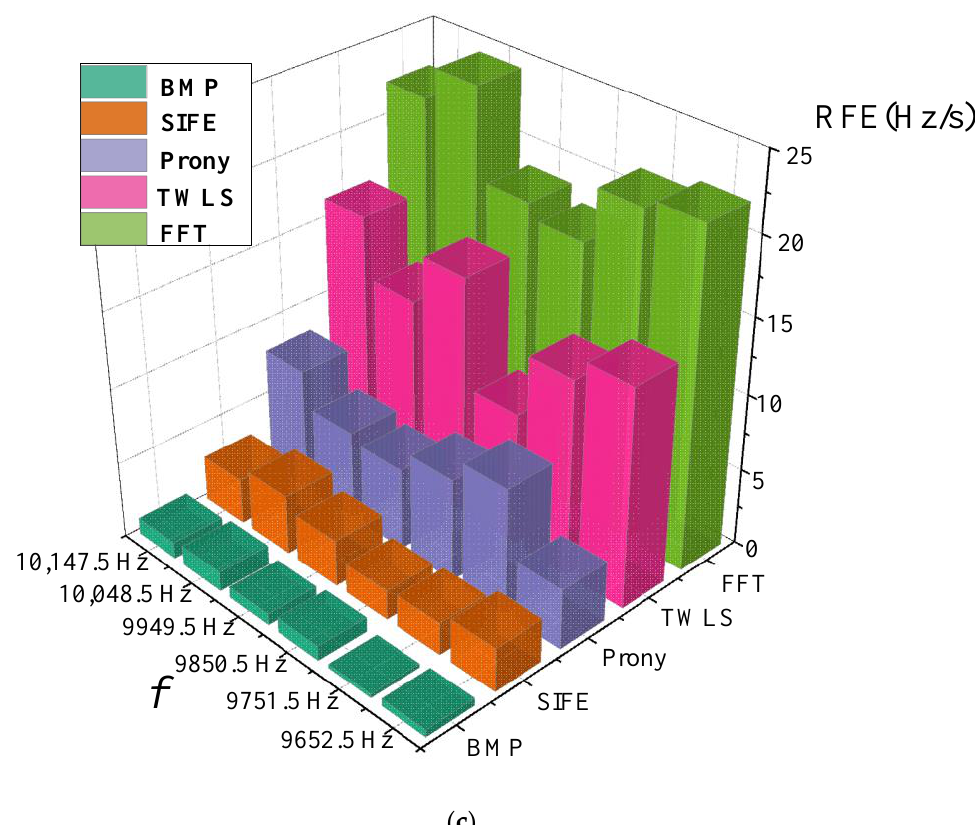
Figure 4. Maximum error of TVE, FE, and RFE under interharmonic and noise interference. ( a ) TVE. ( b ) FE. ( c ) RFE .